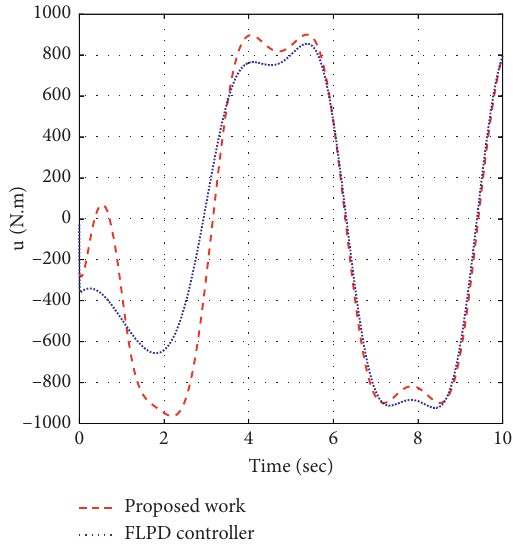
Figure 10: Control effort diagram for the flexible link.